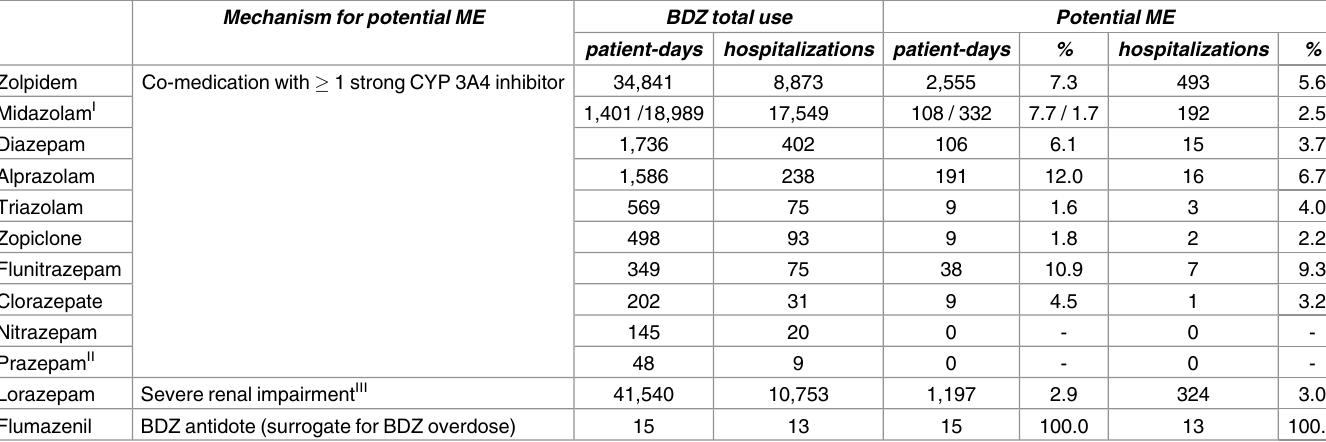
Table 3. Algorithm-based identification of potential